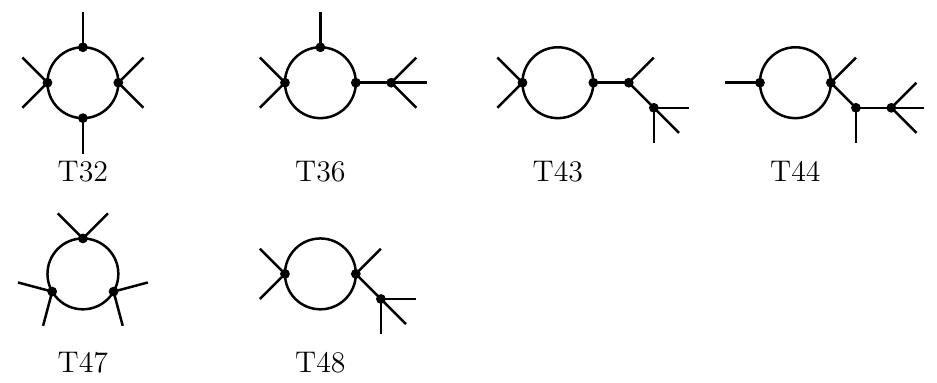
Figure 17 . Topologies discarded because they lead to non-renormalizable operators.